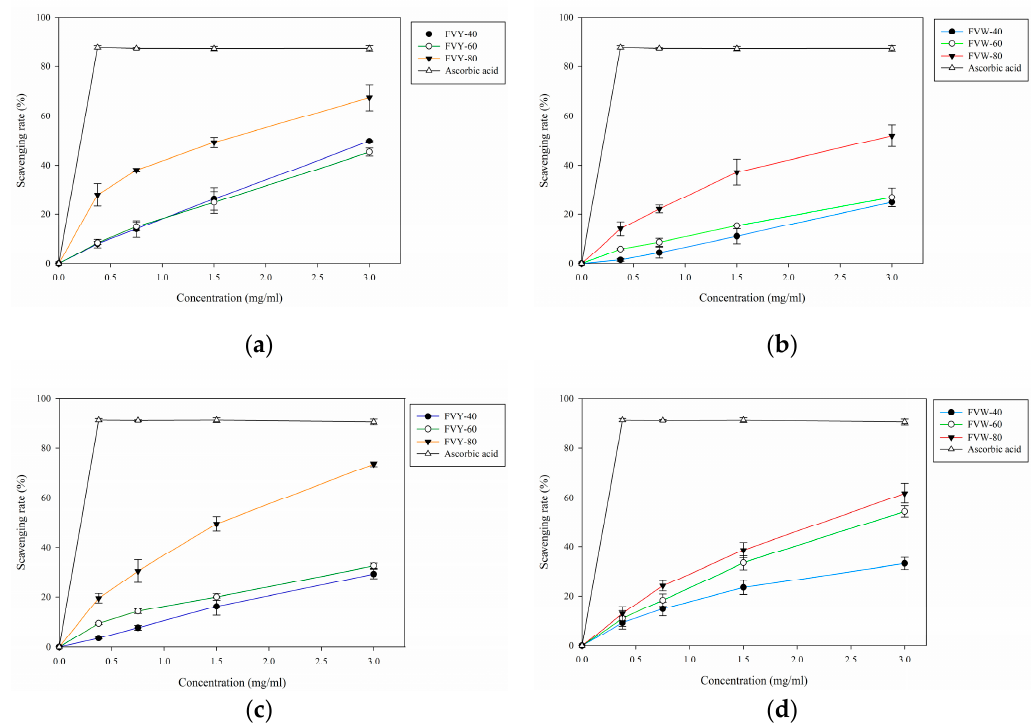
Figure 6. Antioxidant activities of F. velutipes polysaccharides (FVYs) and F. velutipes polysaccharides (FVWs) in vitro . The scavenging rate of ( a ) FVYs and ( b ) FVWs in DPPH radical scavenging assay, and the scavenging rate of ( c ) FVYs and ( d ) FVWs in ABTS radical scavenging assay. The results are presented as means ± standard deviations ( n = 3).